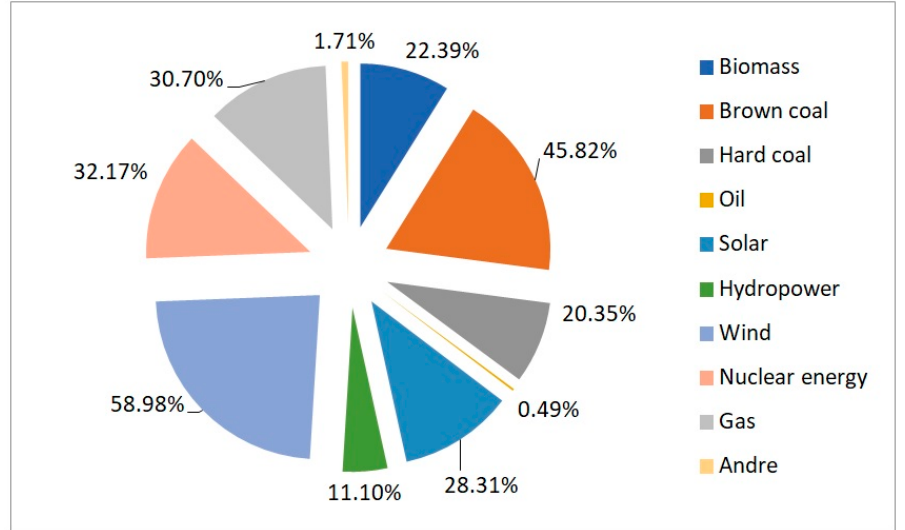
Figure 27. Net electricity production for electricity supply 2020 [74].